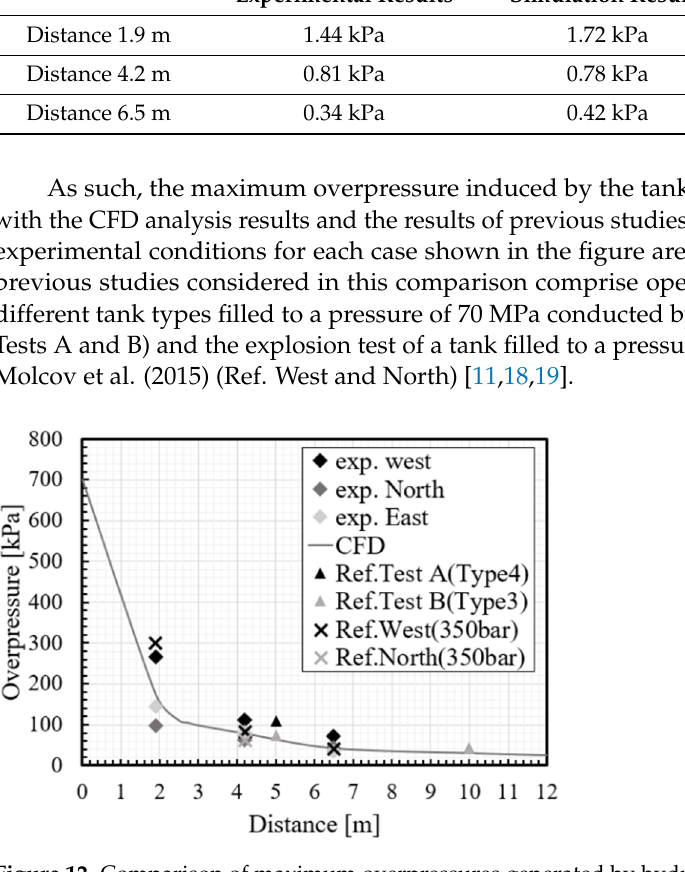
Table 2. Comparison of Maximum Overpressure Experiments and Simulations.